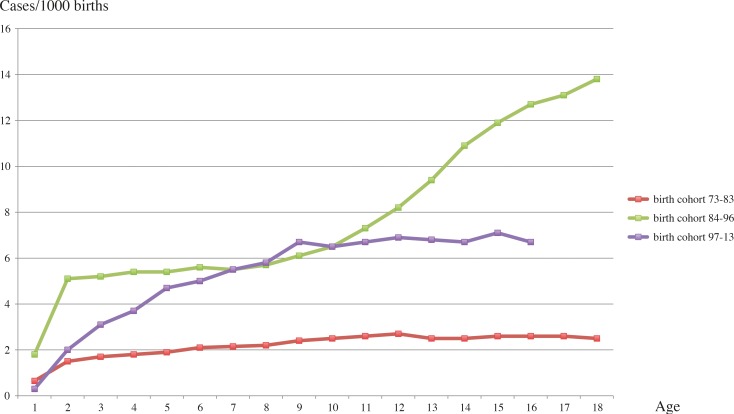
Cumulative incidence of CD by age for the birth cohorts 1973−1983, 1984−1996, and 1997−2013.